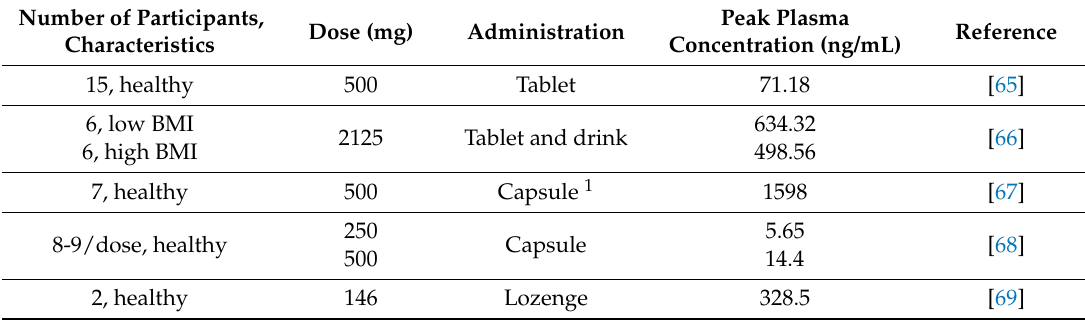
Table 2. Reported resveratrol plasma concentration in humans after a single dose of resveratrol (studies after 2010).